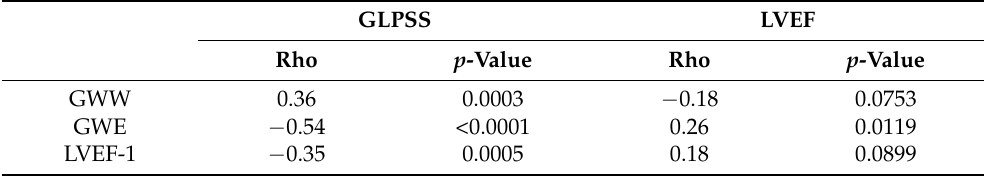
Table 3. Correlation analysis of the standard and newer indices of LV systolic function.